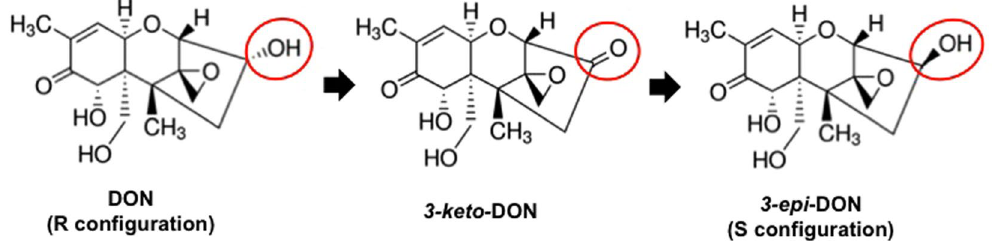
Figure 1. The two-step bacterial transformations of deoxynivalenol (DON) to 3-epi -DON proceeds through the formation of 3-keto- DON intermediate. DON biotransformation to 3-epi -DON in different Gram positive and Gram negative bacterial isolates (including Devosia mutans ) is predicted to proceed through two separate enzymatic steps. The first oxidation step leads to the formation of 3-keto- DON intermediate while the second reduction step leads to 3-epi- DON accumulation.